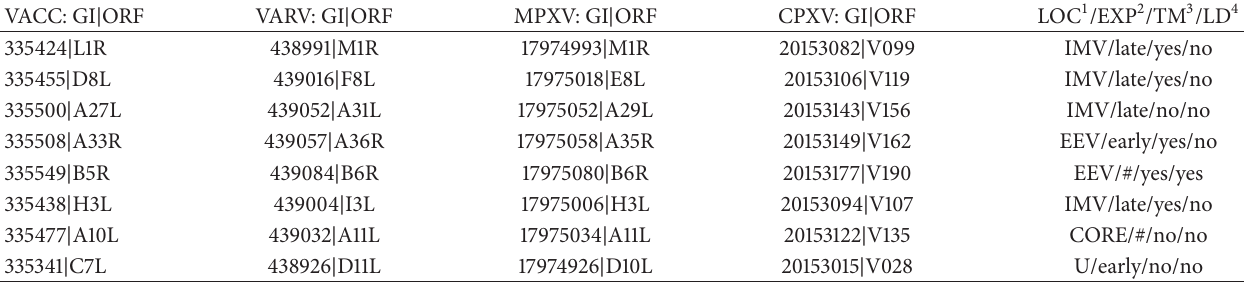
Table 2: Orthopoxvirus proteins contributing to cross-protective